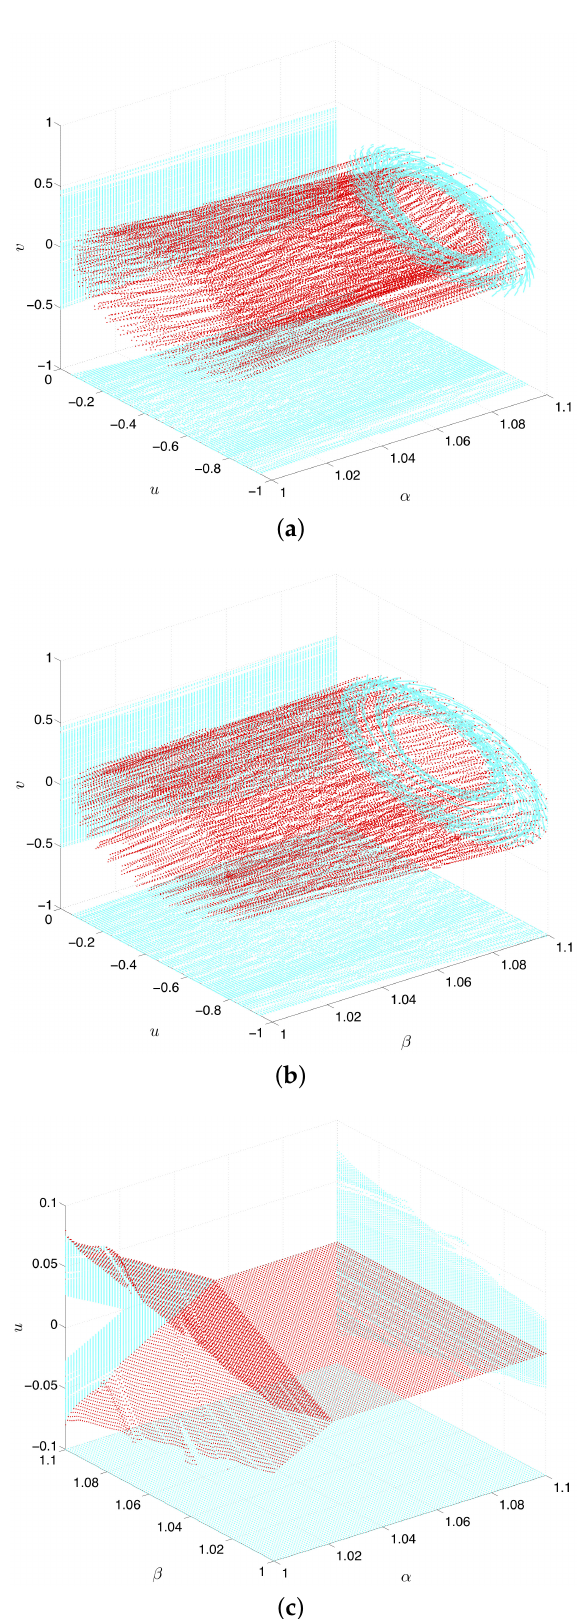
Figure 4. ( a – c ) Bifurcation diagrams of Coriolis force α and centrifugal force β in the frames α uv , β uv and αβ u , respectively, when κ = 1, µ m = 0.48785, q 1 = 0.9988, q 2 = 0.9985, α 1 = 0.024, α 2 =